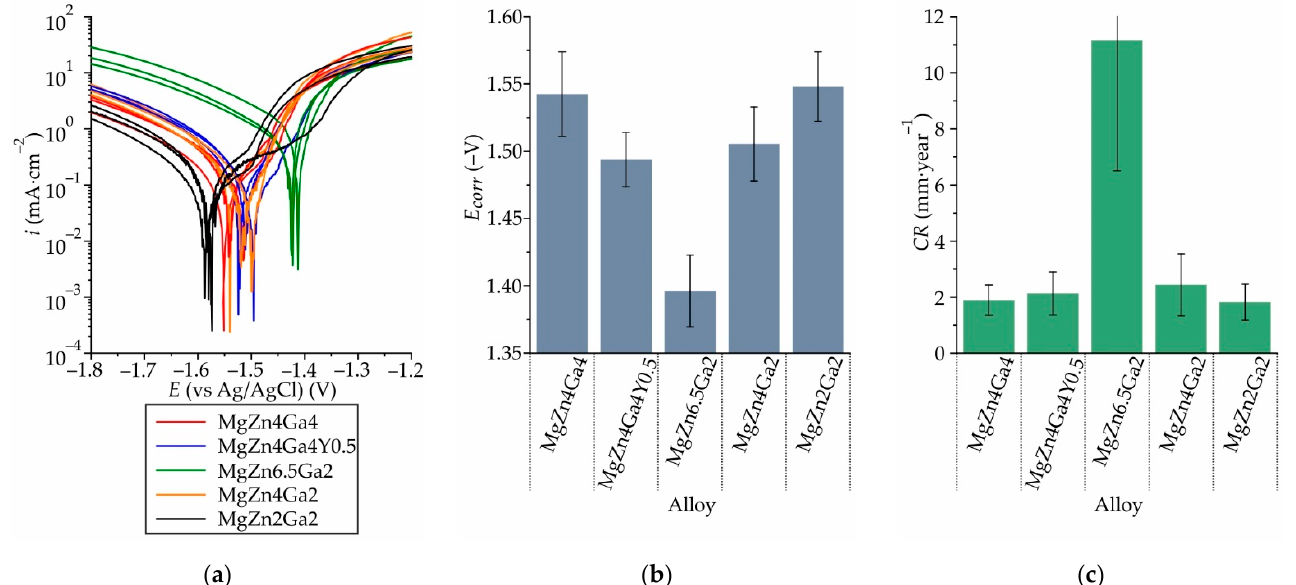
Figure 12. ( a ) Polarization curves, ( b ) corrosion potential ( E corr ), and ( c ) corrosion rate (CR) obtained via electrochemical corrosion testing of the T4 heat-treated Mg–Zn–Ga alloys in Hanks’ solution at 37 °C.